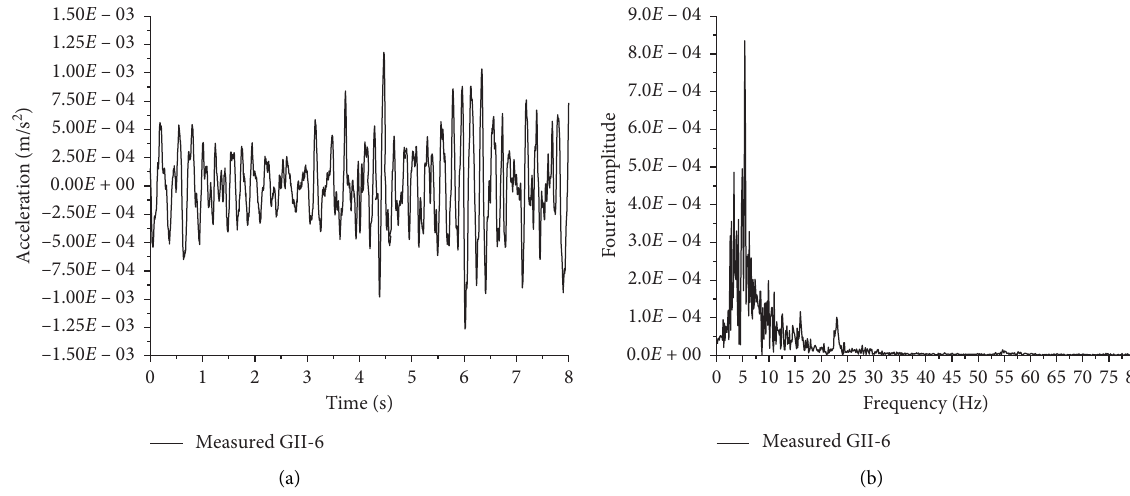
Figure 9: Acceleration: (a) time history and (b) frequency spectrum of